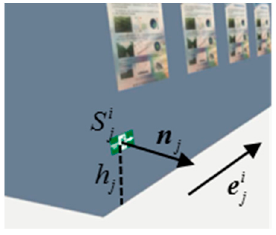
Figure 7. The evacuation sign model.